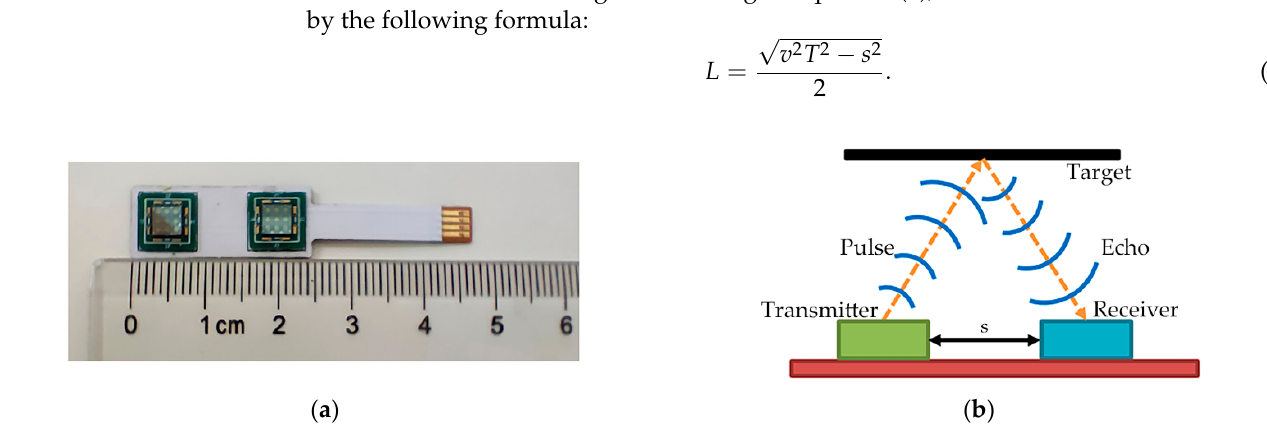
Figure 2. ( a ) The ultrasonic sensor based on PMUTs and ( b ) the target detection process of the sen- sor.